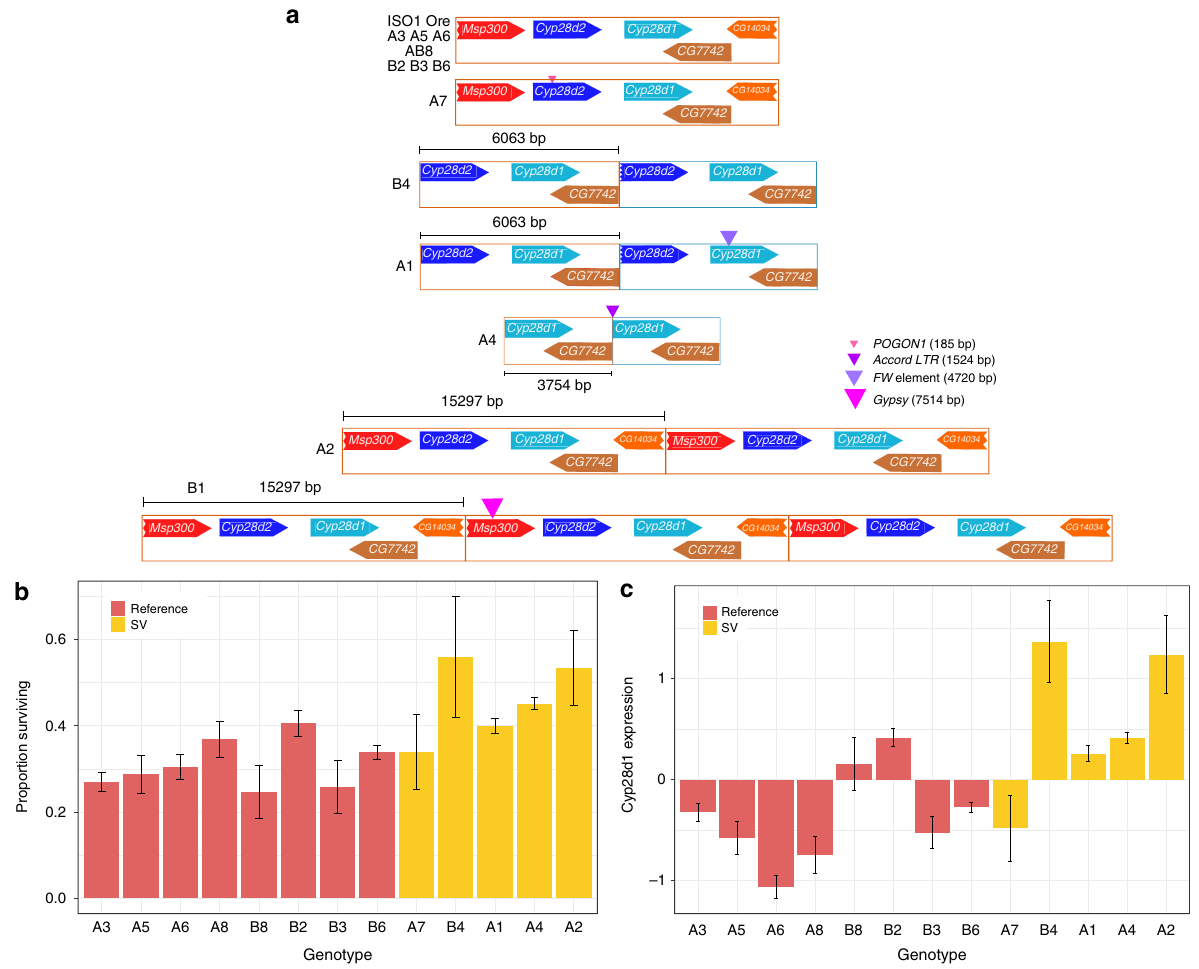
Fig. 3 SV allelic heterogeneity at the nicotine resistance QTL candidate genes Cyp28d1& Cyp28d2 . a Structural alleles at Cyp28d1 and Cyp28d2 genes underlying a nicotine resistance QTL. The most common allele is the reference (ISO1) allele and contains a single copy of Cyp28d1 and Cyp28d2 . All others are private to a single founder strain. A1 and B4 carry the same duplicate but A1 has a FW element inserted into the second Cyp28d1 copy. A2 and B1 possess two and three copies of a 15 Kb segment,respectively, that contains both Cyp28d1 and Cyp28d2 . b Nicotine resistance of RILs as a function of founder allele at the QTL harboring Cyp28d1 and Cyp28d2 . Genotype ordering matches Fig. 2a. A2 and B4 alleles are most resistant to nicotine, followed by A4. A2 possesses a 15 Kb duplication containing full Cyp28d1 and Cyp28d2 , whereas B4 contains duplicate of a full Cyp28d1 and near complete Cyp28d2 . No RIL homozygous for the B1 allele was present in this sample. c Normalized Cyp28d1 expression level in RILs with different founder genotypes at the cis- eQTL for Cyp28d1 (Supplementary Fig. 12). Genotype ordering (L to R) follows genotype ordering (top to bottom) in Fig. 2a. A2 and B4 genotypes, which show highest resistance to nicotine toxicity, also show highest upregulation for Cyp28d1 . Despite A1 and B4 having the same duplication, the Cyp28d1 disrupting TE insertion in A1 is likely responsible for lower expression of the gene in A1. Error bars indicate standard errors of genotypic Cyp28d genes. The expression level of Cyp28d1 in the adult female heads of RILs bearing the A2 genotype is highest among all founder genotypes measured (Fig. 3c). Consistent with this, DSPR Recombinant Inbred Lines (RILs) bearing the A2 genotype show the highest average resistance to nicotine toxicity among the RILs derived from the A set of founders 47 (Fig. 3b). This implies that the extra copies of Cyp28d1 and/or Cyp28d2 account for the increased expression and concomitant resistance to nicotine.